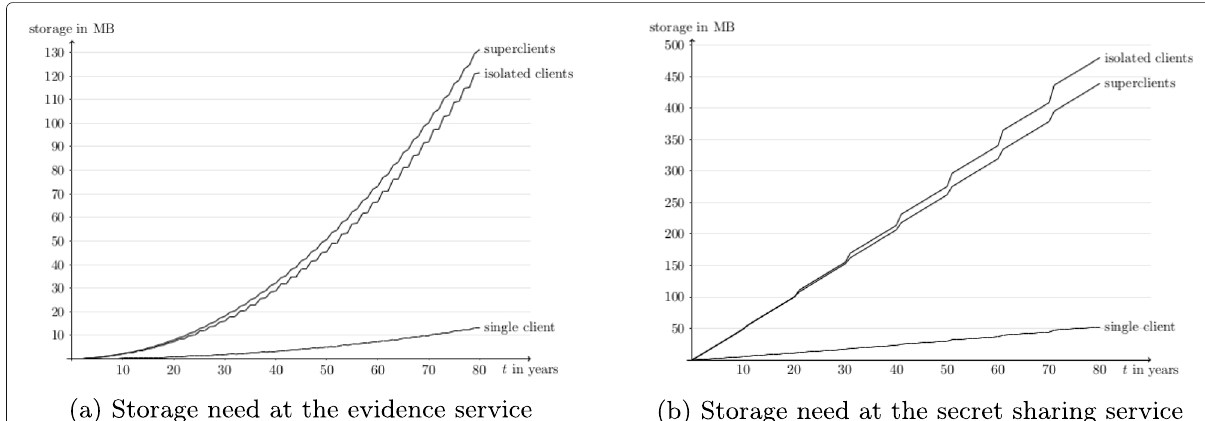
Fig. 2 Plots of MCELSA’s evaluation results concerning storage demand